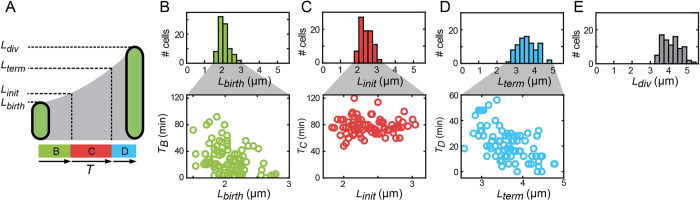
Compensation for size variability.(A) Schematic diagram indicating the cell cycle periods, and the corresponding length of the cell at birth (Lbirth), replication initiation (Linit), termination (Lterm), and division (Ldiv). (B) Histogram of cell lengths at birth, and correlations with the B period. N = 81 cell cycles. (C) Histogram of cell lengths at initiation, and correlations with the C period. D) Histogram of cell lengths at termination, and correlations with the D period. E) Histogram of cell lengths at division.